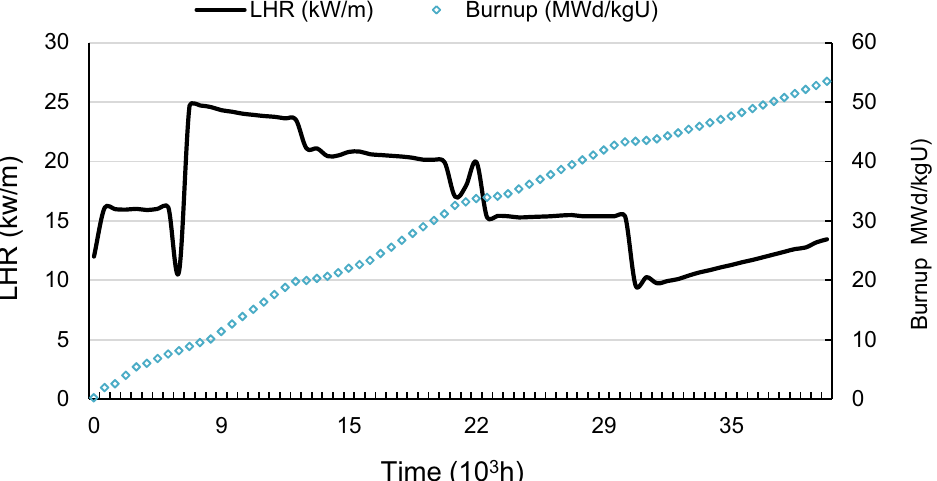
Fig. 2. Variations in fuel rod average linear heat rating (kW/m) and burnup (MWd/kg U) as a function of irradiation time. Table 4. Data obtained from simulation for Zy-4 fuel rod using FRAPCON-3.4. Time